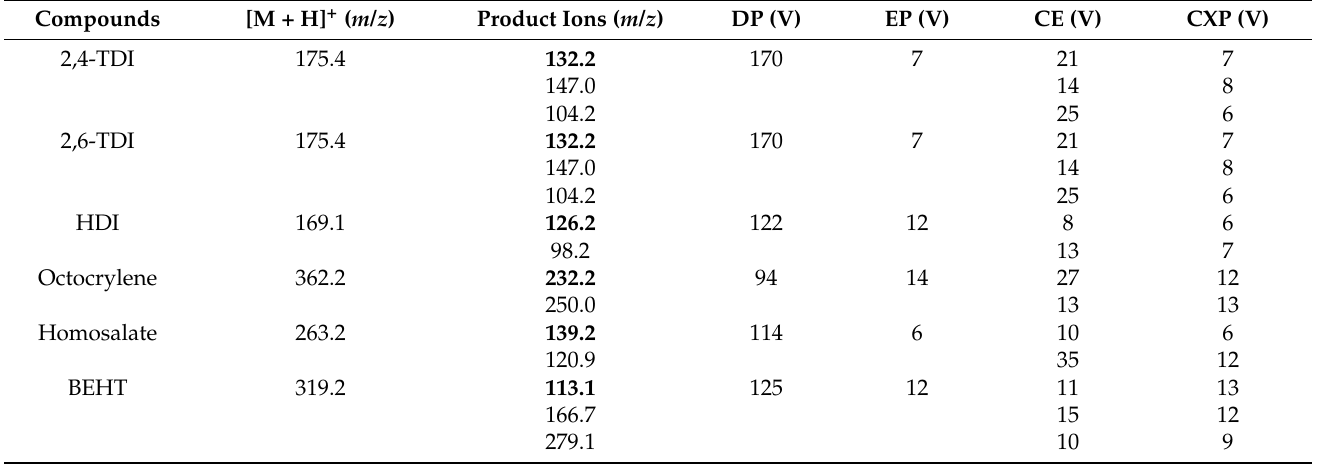
Table 1. Mixture 1 MRM parameters (DP: declustering potential; EP: entrance potential; CE: collision energy; CXP: collision exit potential). Quantifier ions are in bold.